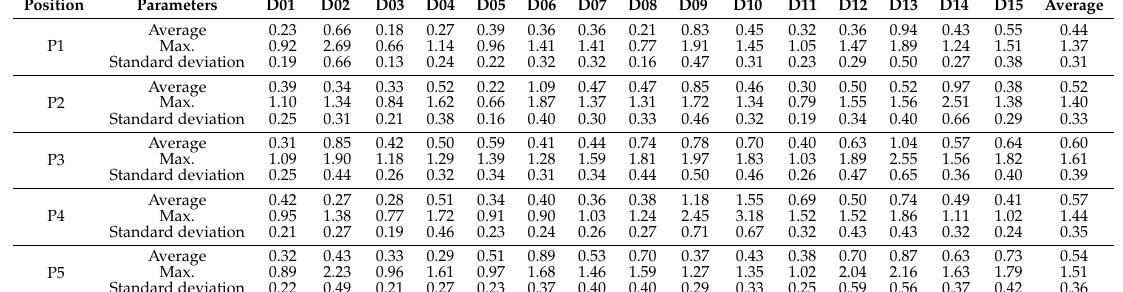
Table 2. Motion error of the proposed PCA-based method compared to laser line scanning calculated on five locations of the laser line for 15 datasets. All data are given in mm.